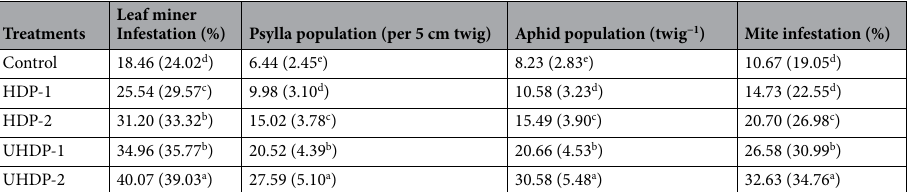
Table 4. Effect of planting density on incidence of insect pests (pooled data for 2015–16 to 2019–20). Figures under parenthesis are transformed values. Means with at least one letter common are not statistically significant using TUKEY’s Honest Significant Difference at 5% Control: Planting at 6 m (row to row) × 6 m (plant to plant) spacing (tree density—277 plants ha −1 ), HDP-1: Planting at 6 m (row to row) × 3 m (plant to plant) spacing (tree density—555 plants ha −1 ), HDP-2: Planting at 4 m (row to row) × 4 m (plant to plant) spacing (tree density—625 plants ha −1 ), UHDP-1: Planting at 4 m (row to row) × 2 m (plant to plant) spacing (tree density—1250 plants ha −1 ), UHDP-2: Planting at 2 m (row to row) × 2 m (plant to plant) spacing (tree density—2500 plants ha −1 ).